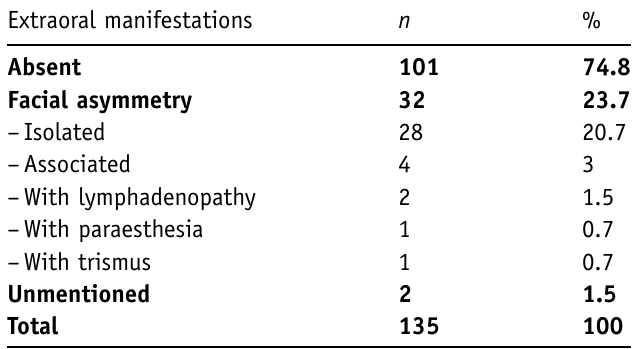
Fig. 3. Distribution of locations of central odontogenic fi broma. (A) According to the involved jaw (maxilla or mandible). (B) According to the site involved within the maxilla or mandible. The sum of the theses percentages is higher than 100% because a lesion can be located in several sites. This fi gure was made using Servier Medical Art templates (cid:3) https://smart.servier.com. Table III. Radiological features of central odontogenic Table I. Extraoral features of central odontogenic fi broma. fi